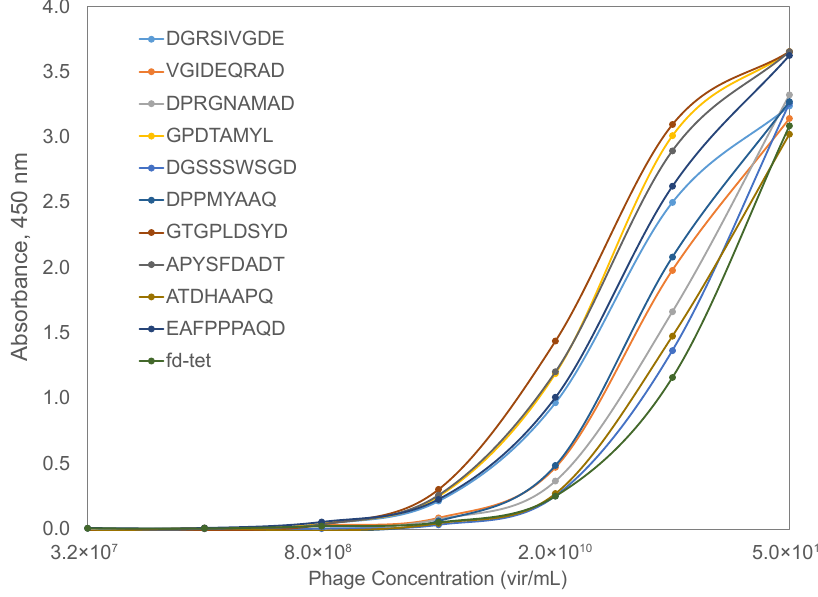
Figure 7. ACE2-binding phages displaying SARS-CoV-2 spike RBD-mimotopes as characterized by an indirect ELISA. Serial dilutions of phages were incubated with a bound ACE2 receptor, followed by incubation with a rabbit anti-phage IgG and an HRP-conjugated goat anti-rabbit IgG. Signal was produced using a TMB substrate and endpoint absorbance at 450 nm was measured after a 30-min incubation. Candidate RBD-binding phages were compared to the wildtype fd-tet phage (dark green).